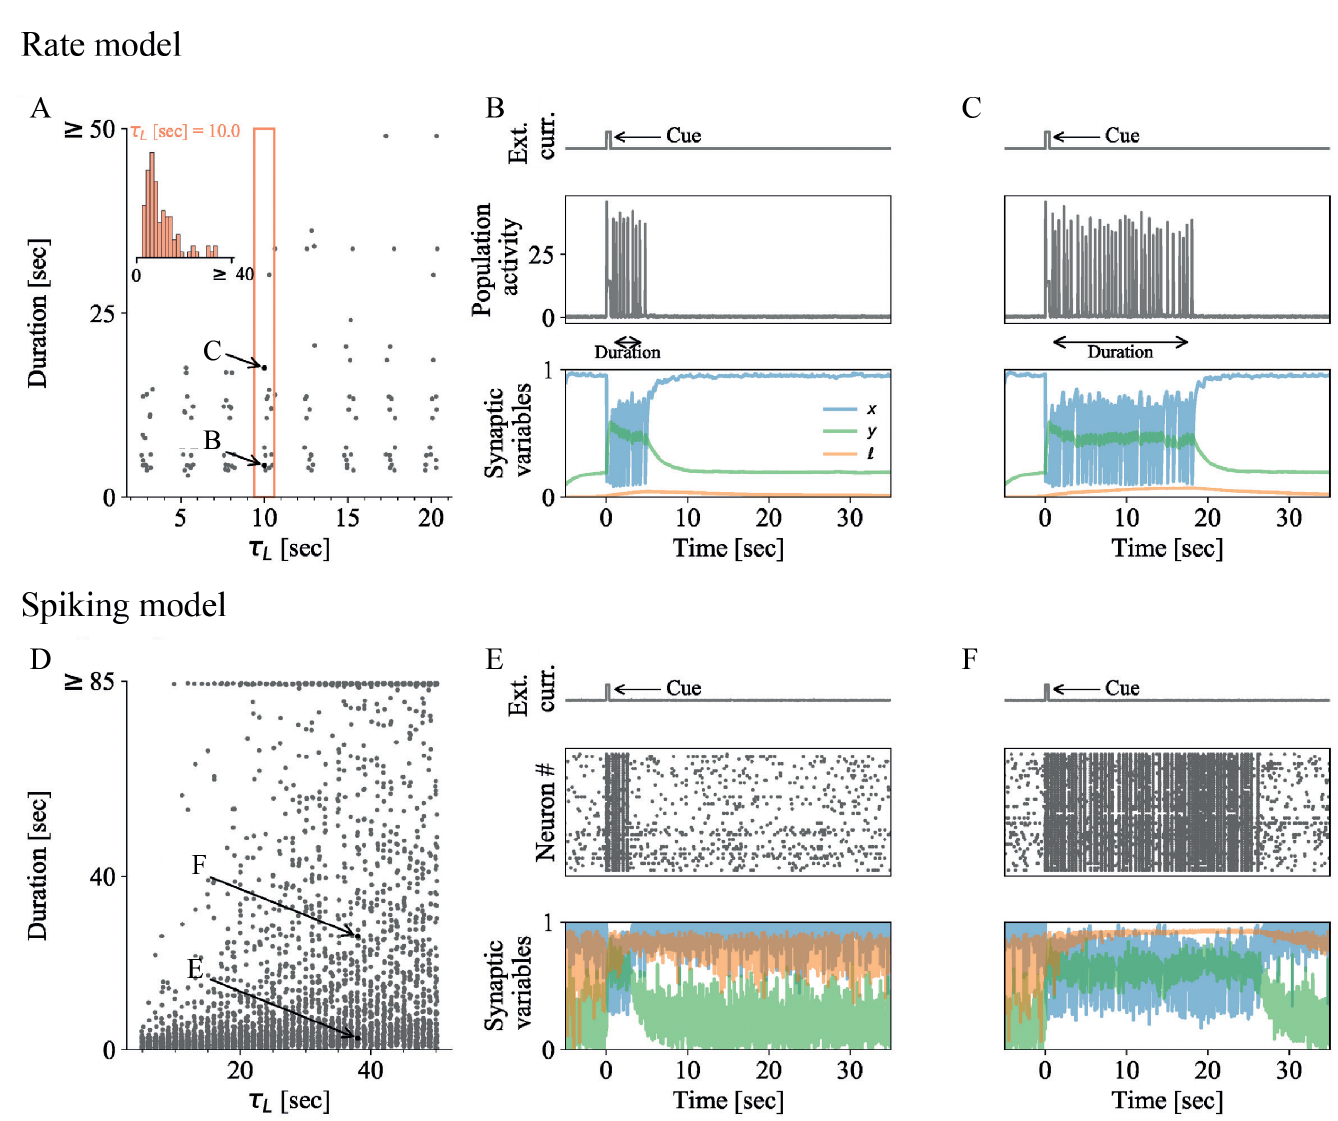
Fig 5. Weak LPA signaling implements slow modulation of the mean transient WM duration via its influence on presynaptic calcium binding. A-C Analysis of the STP+LPA rate model (see Models and methods and Table C in S1 Text). Parameters: Δ U = 0.1, M = 0.2, U b = 0.16, σ = 0.1, remaining parameters: Table D in S1 Text. A WM durations for 15 simulations at each of eight values of τ . Durations of transient activity slowly increase with τ . Inset: Distribution of transient WM L L durations of 100 simulations at τ L = 10sec. B-C Two simulations at τ L = 10sec. Panels as in Fig 4. D-F Analysis of a STP+LPA spiking network model (see Models and methods, Table A in S1 Text). Parameters: Δ U = 0.1, M = 0.6, U = 0.2, remaining parameters: Table B in S1 Text. D Transient WM durations for 100 simulations for b each of 46 values of τ L . The time constant of presynaptic LPA unbinding τ L regulates the duration of transient active WM representations across a broad range of biologically realistic values. E-F Two simulations for τ = 38sec with different transient durations. Panels as in B and C but the subplot in the center shows a rasterplot L of 50 neurons of the selective population